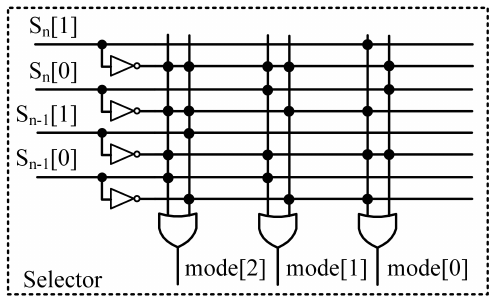
Figure 8. Logic gate circuit of